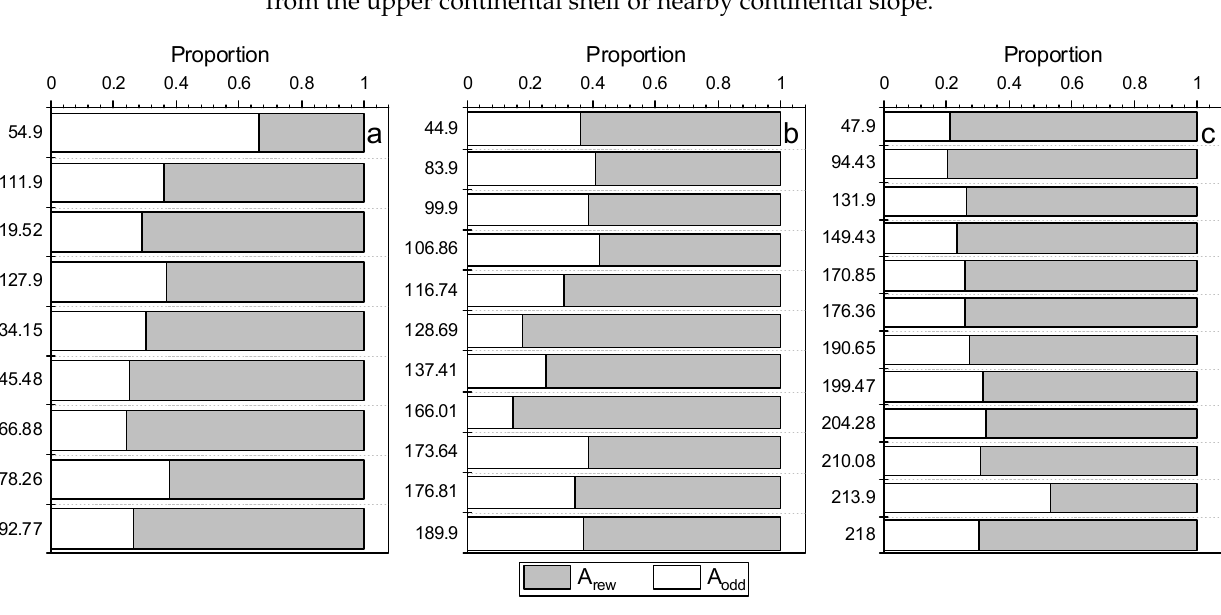
Figure 6. Relative proportion of n-alkanes without an even/odd carbon number preference (A rew )and odd carbon number dominant n-alkanes (A odd ) of n- alkanes in sediment samples from ( a ) W01B, ( b ) W02B, and ( c ) W03B. Blank area and shaded area represent A odd and A rew , respectively.